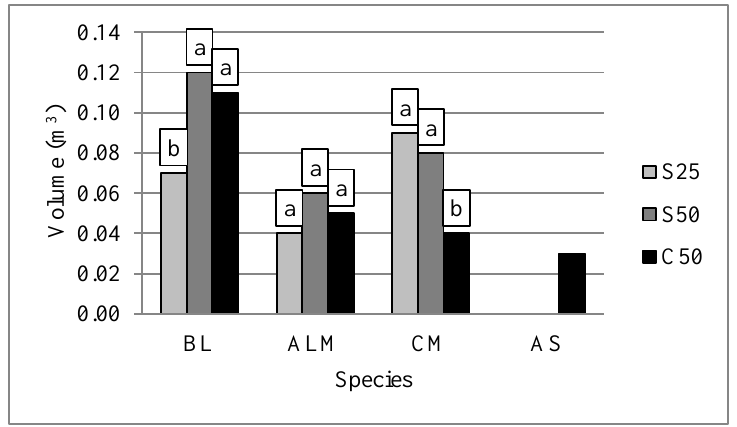
Figure 5. Median volume of the studied tree species in individual groups of research plots. Notes: BL, ALM, CM, AS — explanations as in Figure 2, different letters indicate significant differences ( p ≤ 0.05) according to the K – W test between treatments within a species.